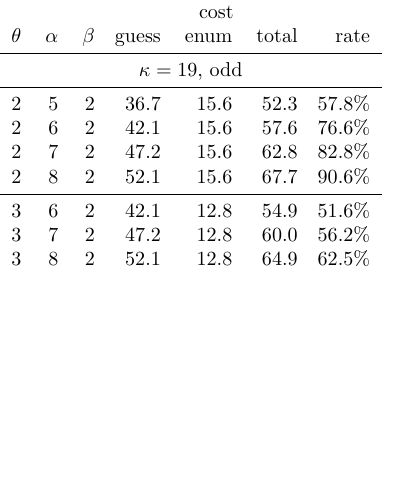
Table 13: Experimental results for New Hope parameters and number of bit-flips κ = 19; for details see Table 12.